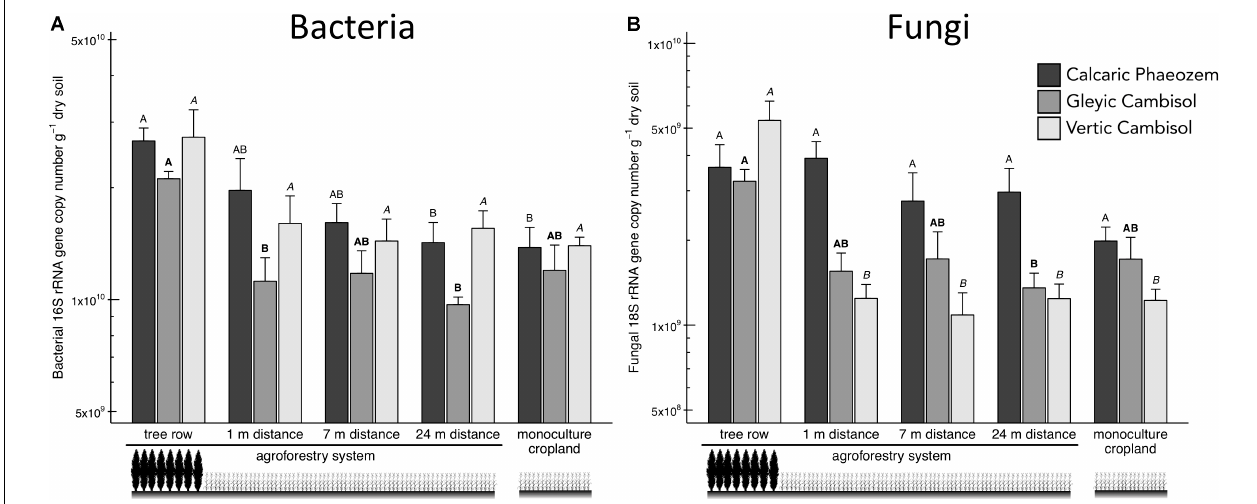
FIGURE 2 | (A) Bacterial 16S rRNA and (B) fungal 18S rRNA gene abundance in soils of three paired temperate agroforestry and monoculture cropland systems. Means (bars are standard errors; n = 4) with different uppercase letters of the same font indicate significant differences among the sampling locations (the tree row, 1, 7, and 24 m within the crop row of the agroforestry and the monoculture croplands) within one soil type (one-way ANOVA with Tukey’s HSD test of log 10 -transformed data at p <